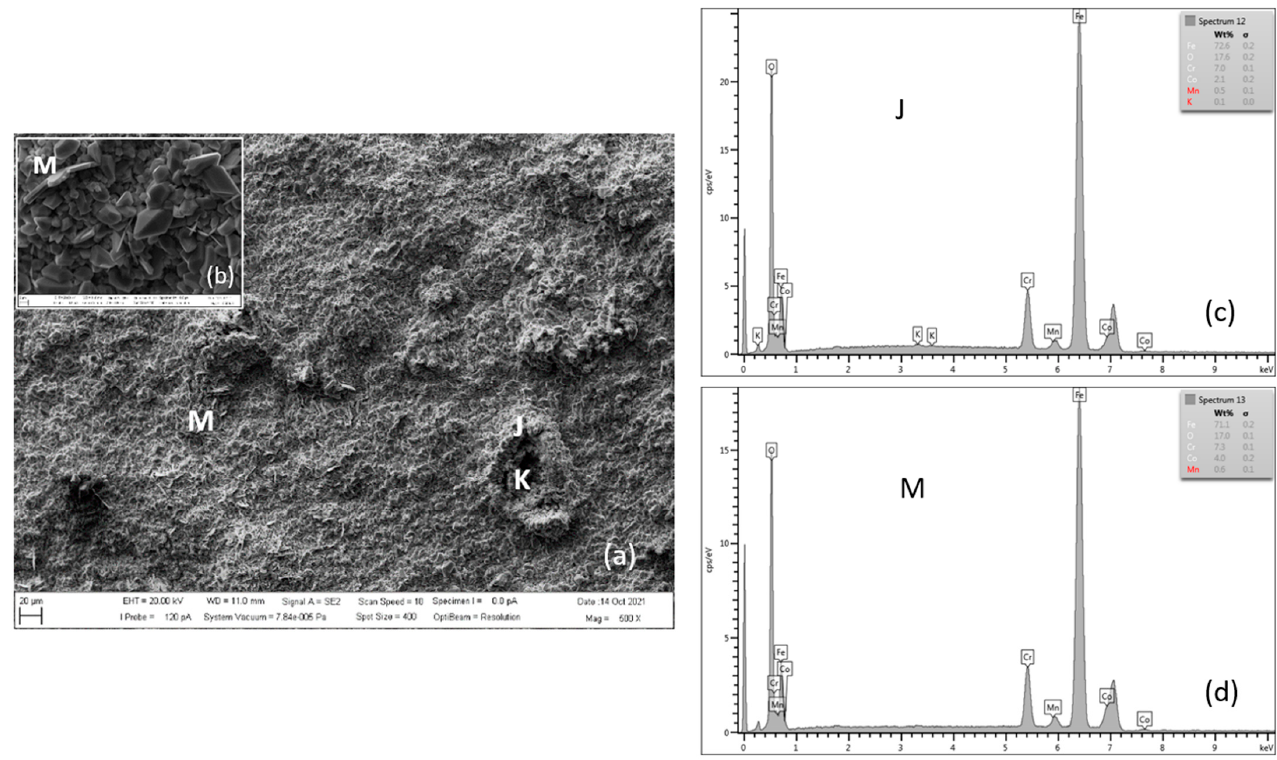
Figure 16. SEM morphology of surface layer of MarBN steel oxidized for 3000 h at 650 °C ( a ), with M location detail ( b ), EDX energy spectrum of steel oxide surface ( c , d ). location detail ( b ), EDX energy spectrum of steel oxide surface ( c , d Table 10. Quantitative EDX analysis, sample MarBN oxidized for 3000 h at 650 °C (in wt.%).